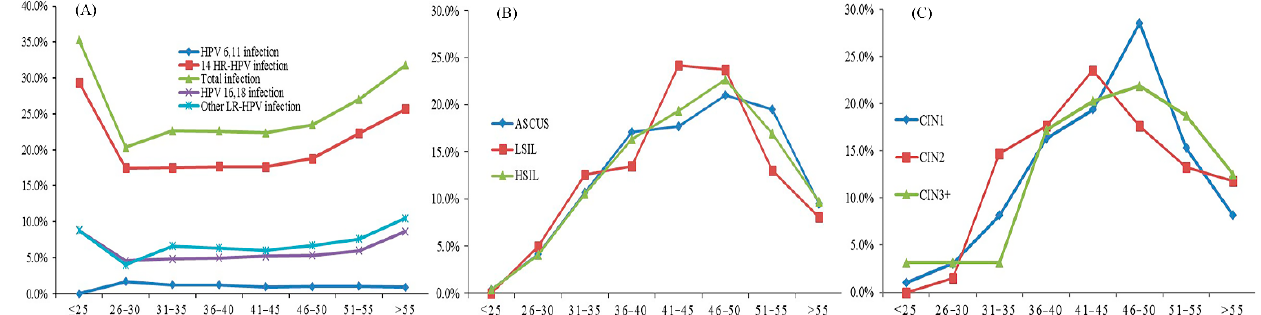
Figure 1. ( A ) The HPV infection rate, ( B ) cytology distribution, and ( C ) pathology distribution in different age groups.